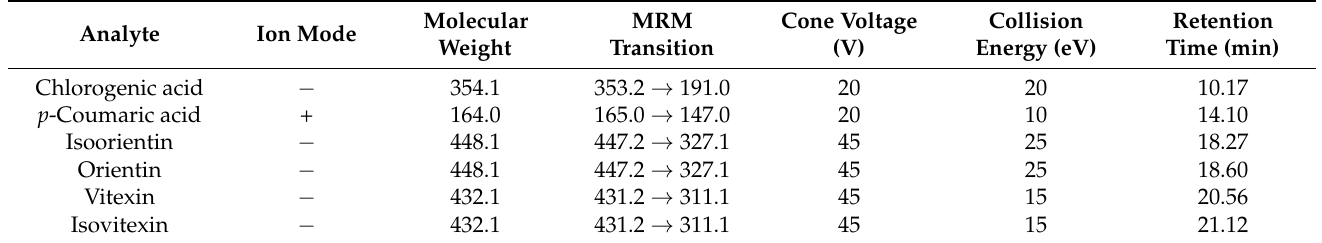
Table 5. LC–MS/MS MRM transitions for quantitative analysis of markers in P. pubescens